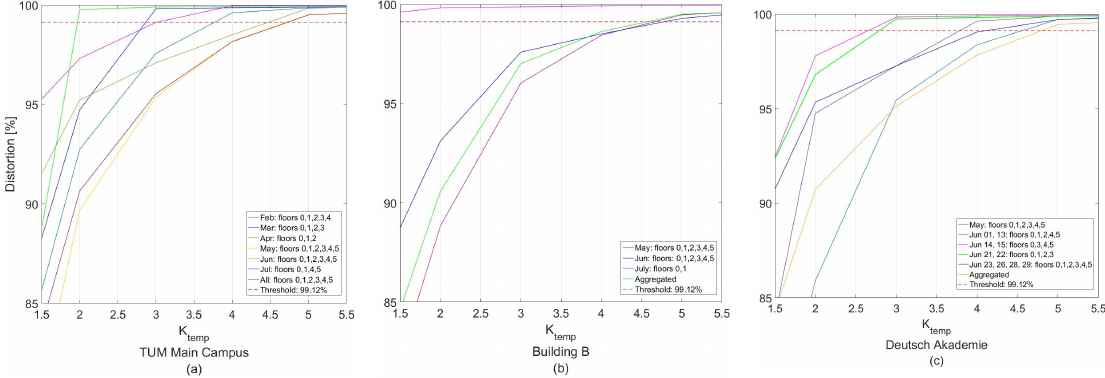
Figure 15. Elbow method result for three test buildings ( a ) TUM Main Campus, ( b ) Building B, ( c ) Deutsche